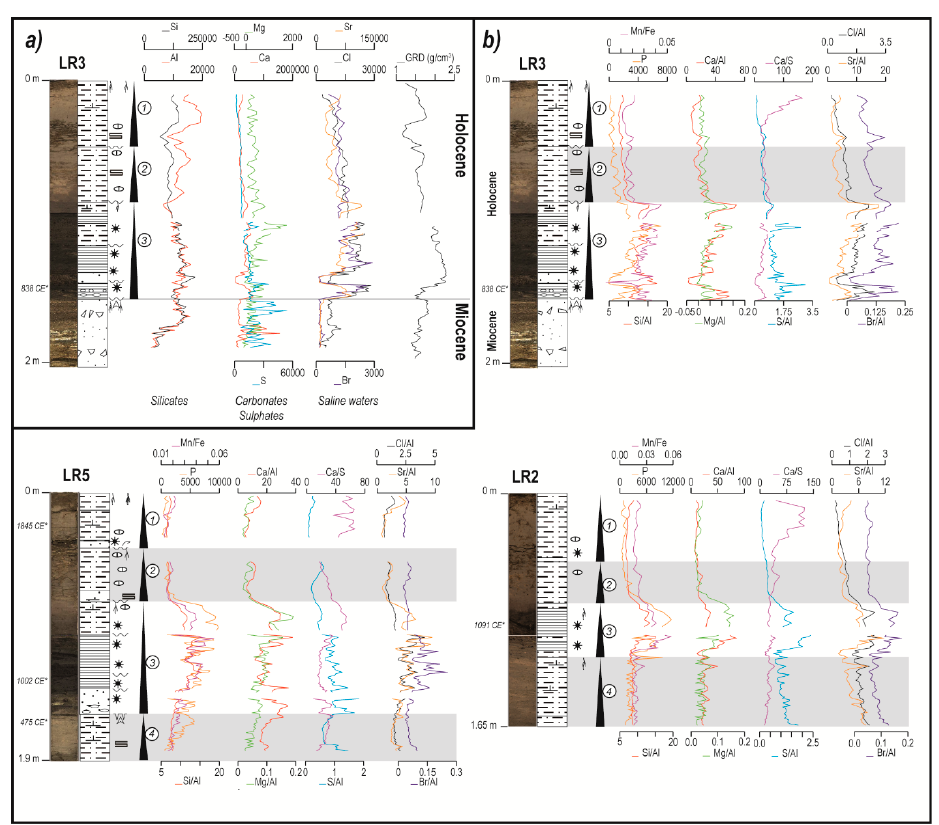
Figure 6. Geochemical logs for the studied cores, with the same key as for Figure 3. ( a ) Single element plots and gamma ray density (GRD). ( b ) Geochemical ratios and P log for the studied cores. Grey rectangles: sequences characterized by a greater amount of pedogenic features.